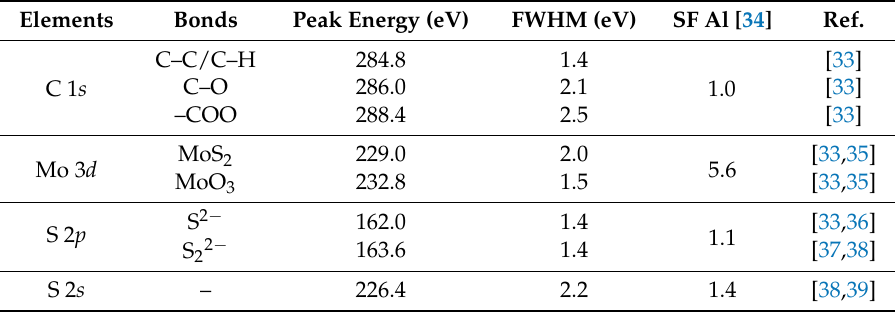
Table 3. Spectral fitting